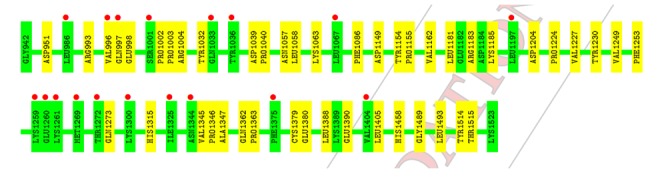
DOI:
http://dx.doi.org/10.7554/eLife.22567.033